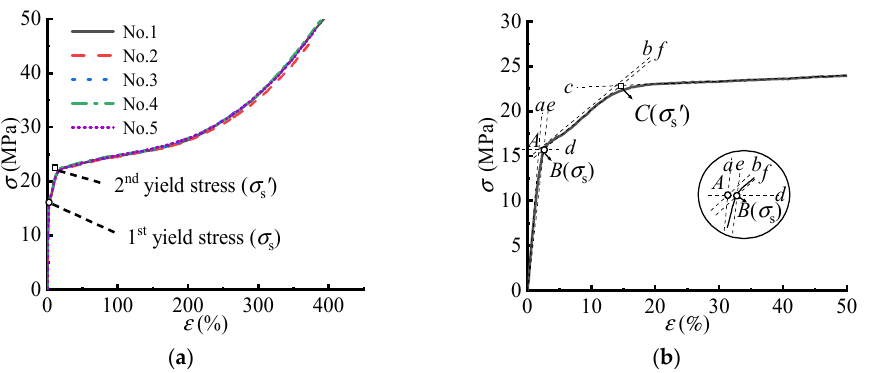
Figure 4. The σ ε− curves and strengths defined by the existing design code. ( a ) The σ ε− Figure 4. The σ − ε curves and strengths defined by the existing design code. ( a ) The σ − ε curves. curves. ( b ) The points defining the yield stresses. ( b ) The points defining the yield stresses.